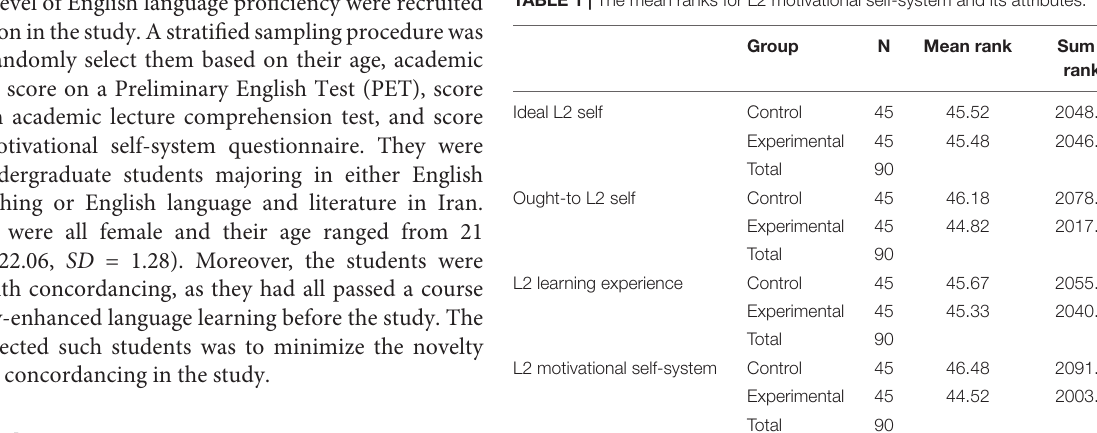
TABLE 1 | The mean ranks for L2 motivational self-system and its